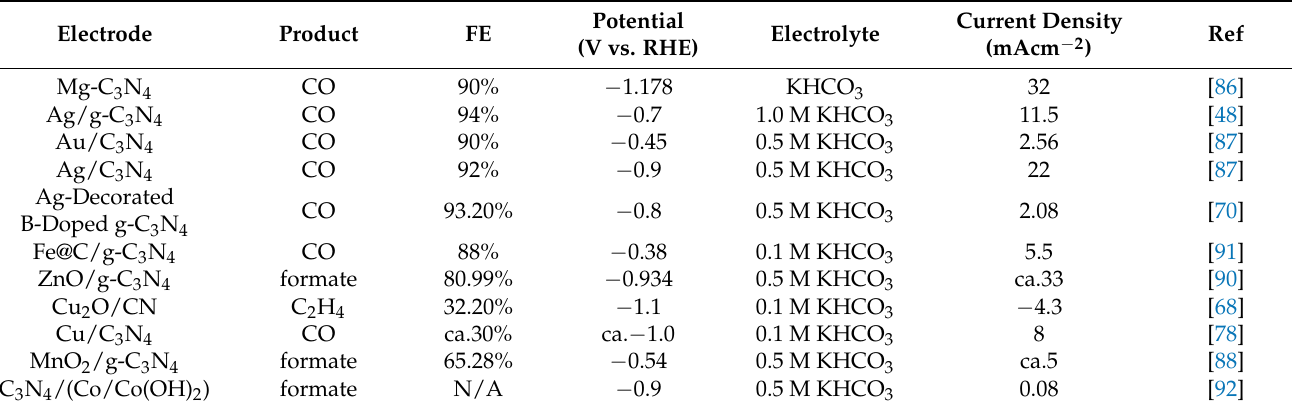
Table 4. Electrocatalytic parameters of single metal doped g-C 3 N 4 catalysts in eCO 2